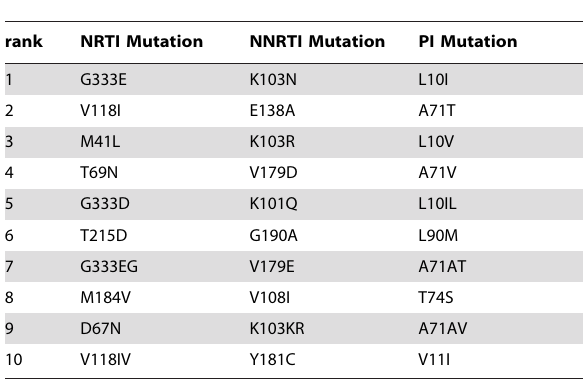
Table 3. Transmitted Drug Resistance by drug class. New York State 2006–2008.